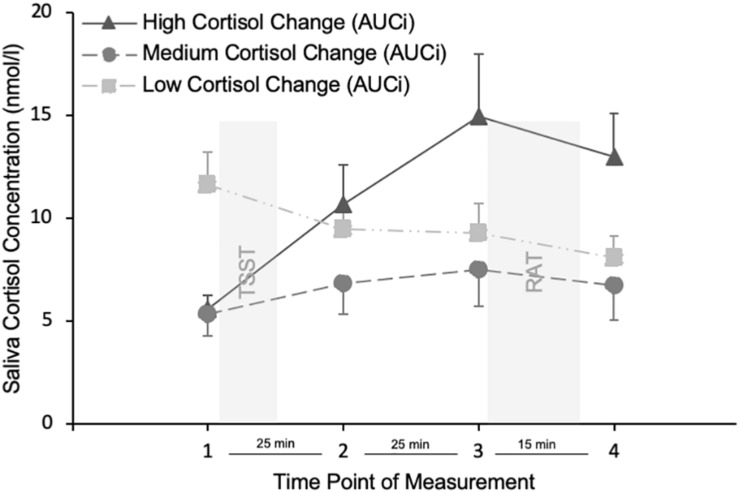
Cortisol concentration at the four time points of measurement. Only for displaying reasons, participants were divided into low medium and high cortisol change groups, based on their AUCi values. TSST = stress induction using the Trier Social Stress Test. RAT = holistic processing task using the Remote Associates Test. Error bars indicate the standard error of the mean.